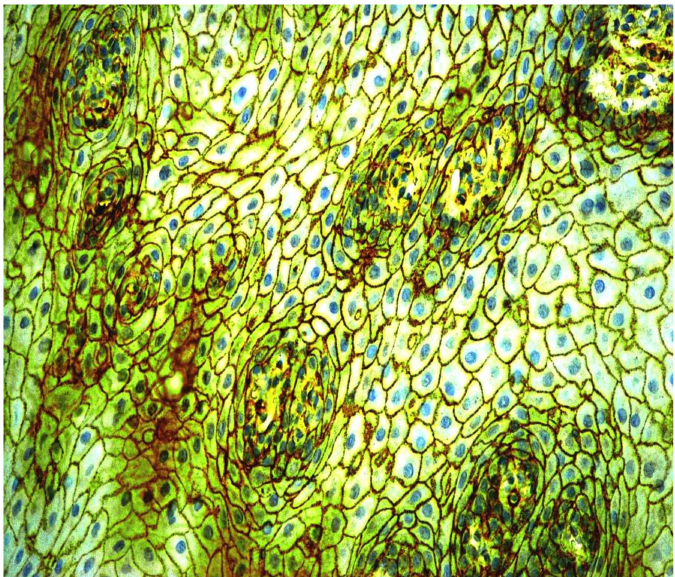
Figure 9. Immunohistochemical visualization of the CD9 marker in the cell membranes of epithelium and its exosomes of oral leukoplakia. Immunoperoxidase, anti- CD9, original magnification 400 × . CD9 protein expression was present also in the ductal epithelium and microparticiples in the lumen of small salivary glands located under the leukoplakia (Figure